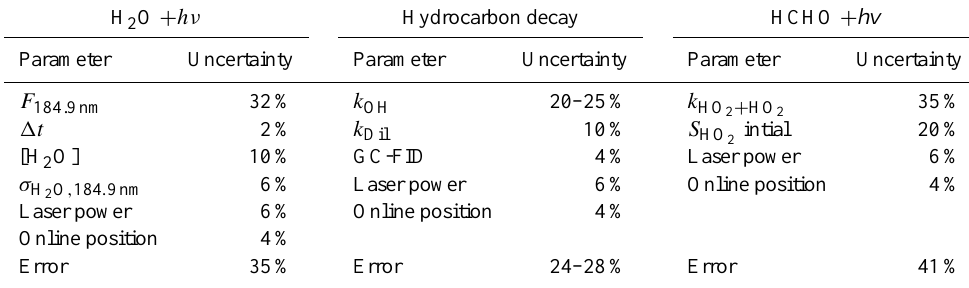
Table 2. The systematic uncertainties to 2 σ in the various parameters that determine the accuracy in the OH and HO 2 calibration factors for all three calibration methods. Total accuracy is taken as the sum in quadrature of the individual uncertainties. The Online position error is the approximate error in the maximum line intensity that is achieved when positioning the laser wavelength at the centre of the OH transition. H 2 O + hν Hydrocarbon decay HCHO +